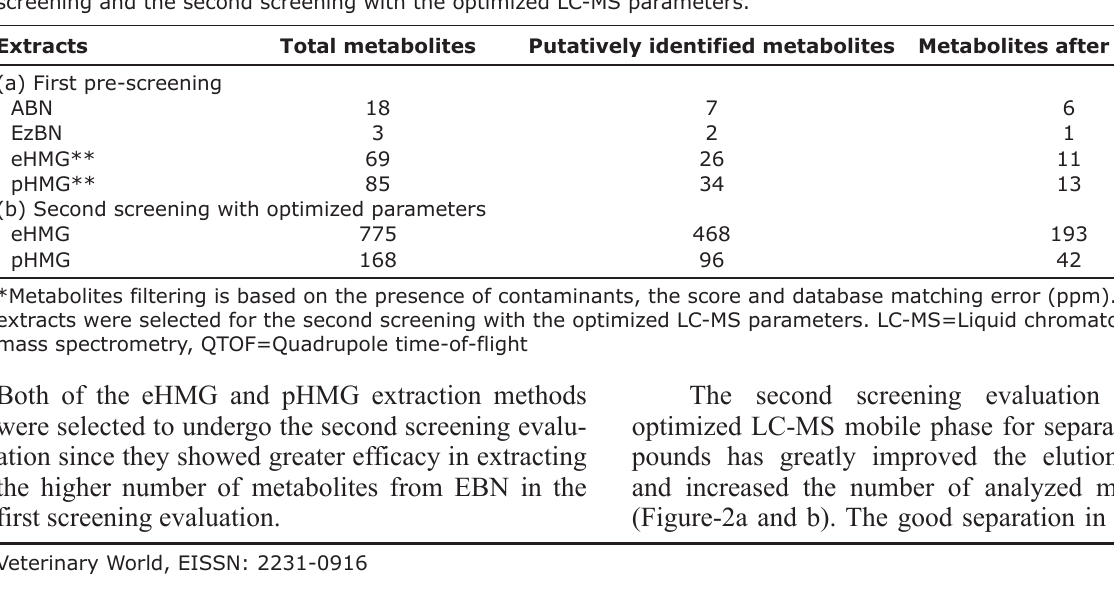
Table-2: Number of metabolites detected and identified by QTOF LC-MS in each of the extracts for the first pre- screening and the second screening with the optimized LC-MS parameters. Extracts Total metabolites Putatively identified metabolites Metabolites after filtering*